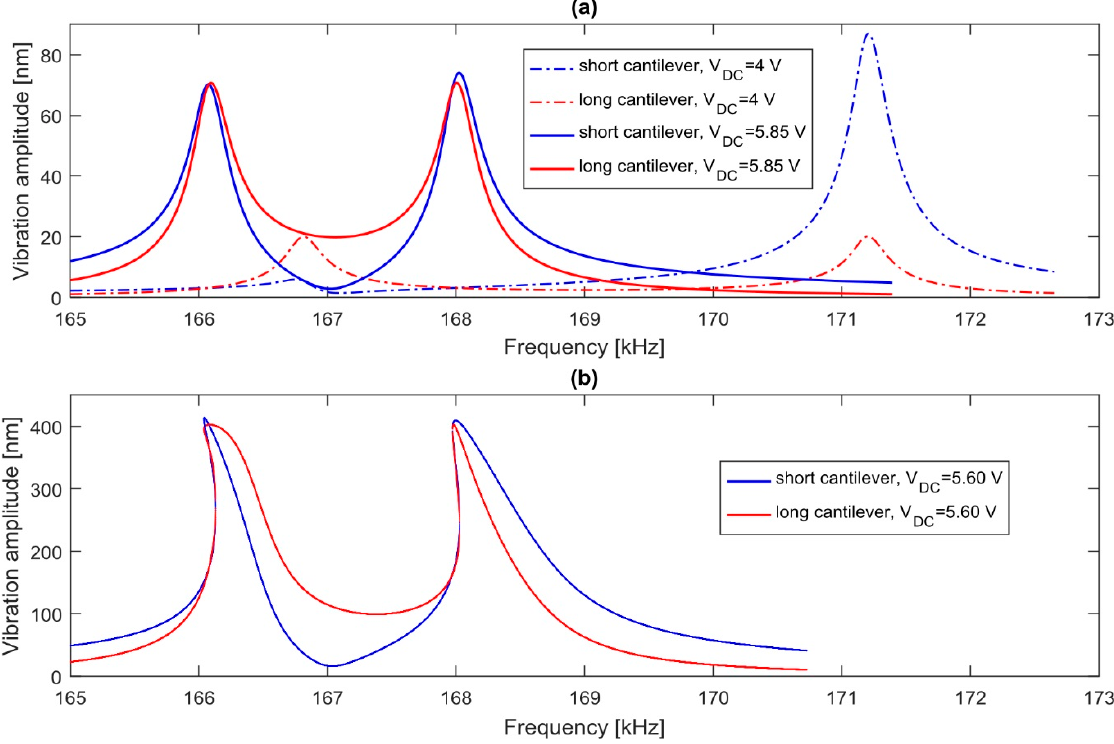
Figure 2. Frequency responses of the two cantilevers ( a ) with an AC voltage of 10 mV; ( b ) and 60 mV.